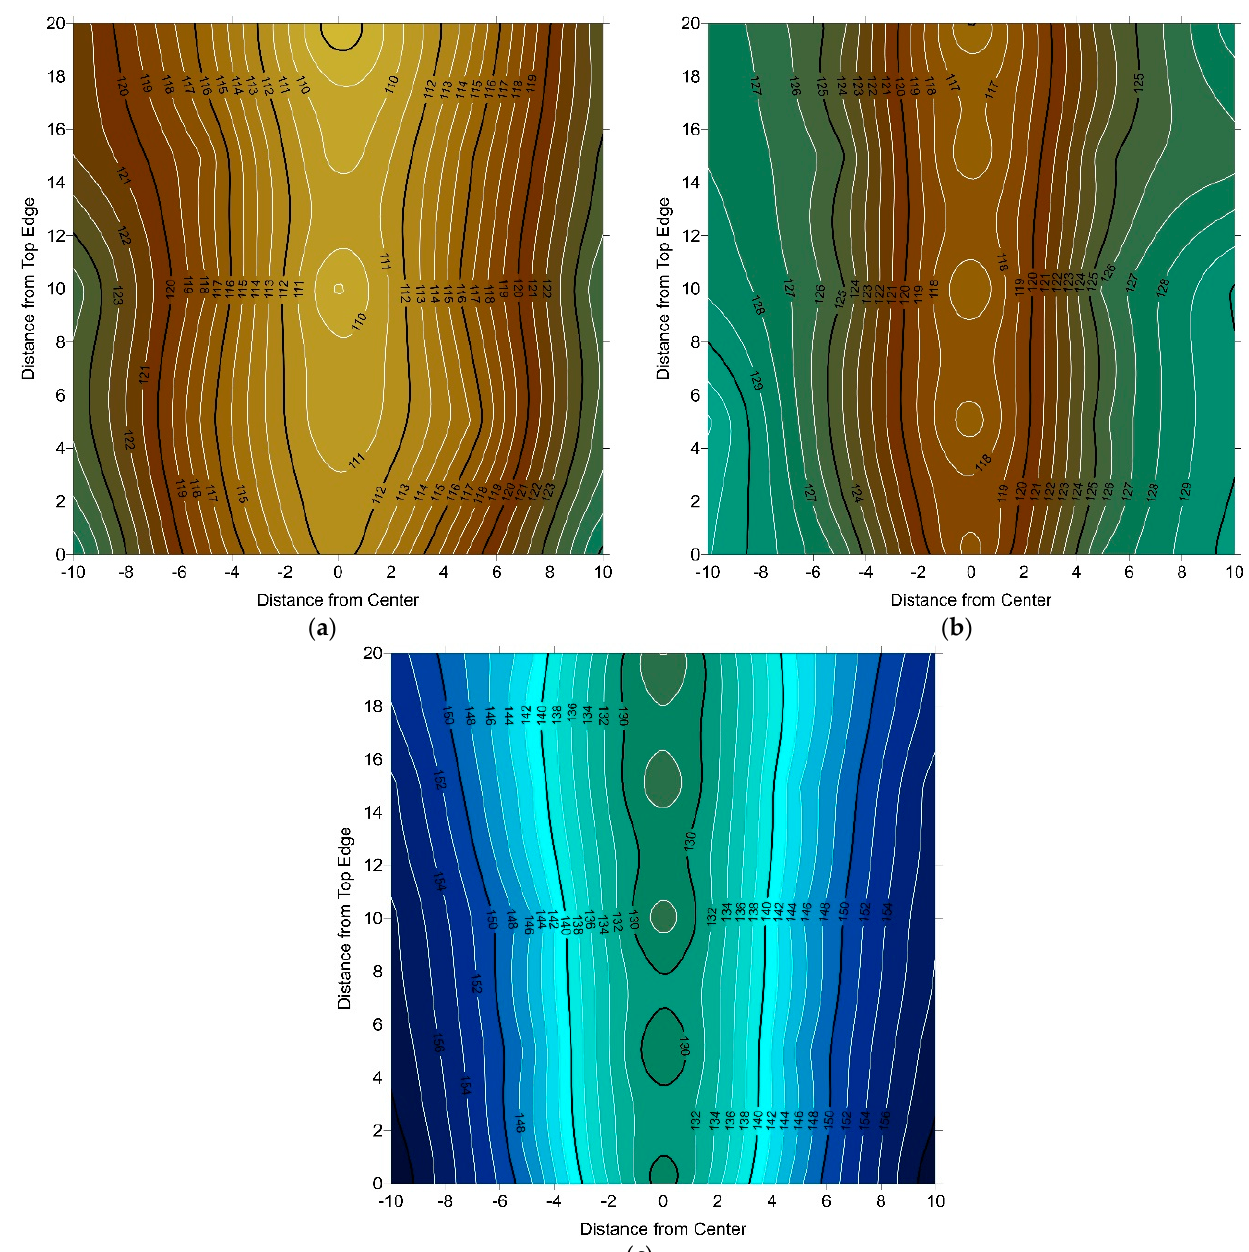
Figure 13. Color coded contour maps for the hardness (HV) values recorded on the longitudinal section (LS) of the Cu billets processed via ECAP processing after ( a ) 1-P, ( b ) 2-Bc and ( c ) 4-Bc.